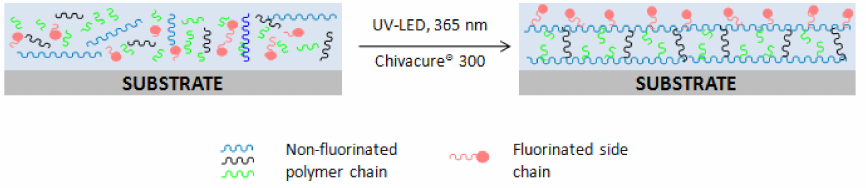
Figure 4. Illustration of the possible migration of fluorinated component in the system upon UV-LED